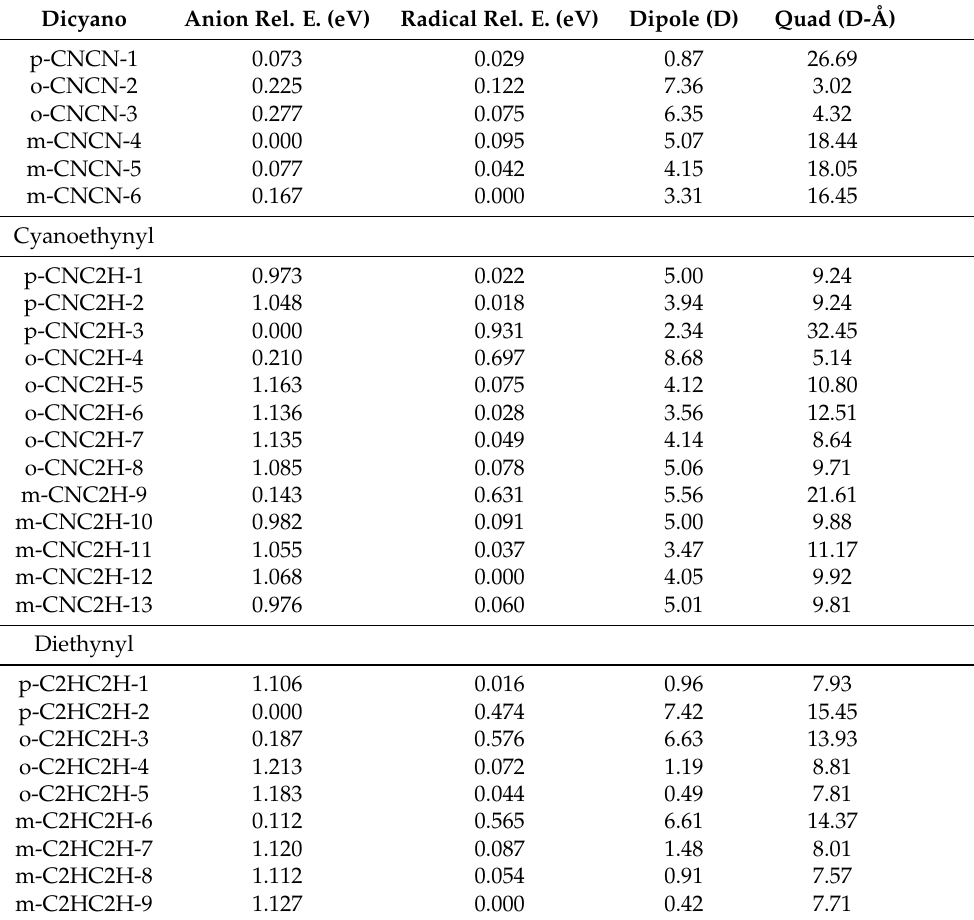
Table 1. B3LYP/aug-cc-pVDZ relative energies along with the total dipole moments and largest quadrupole moment contributions of the difunctionalized benzene derivatives. Dicyano Anion Rel. E. (eV) Radical Rel. E.